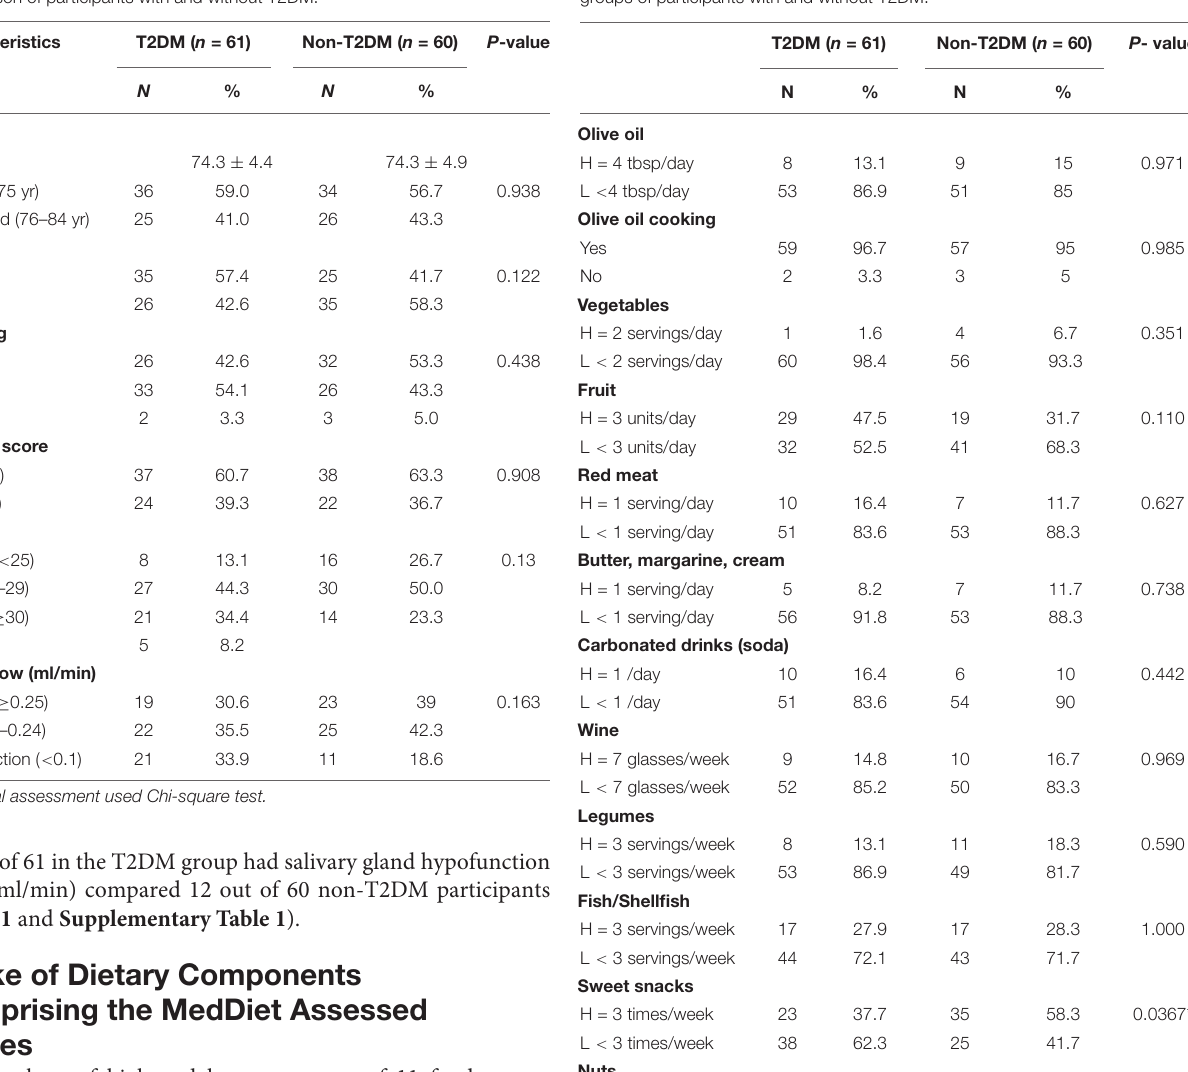
TABLE 2 | Comparison of MEDAS scores of adherence to a Mediterranean diet in groups of participants with and without